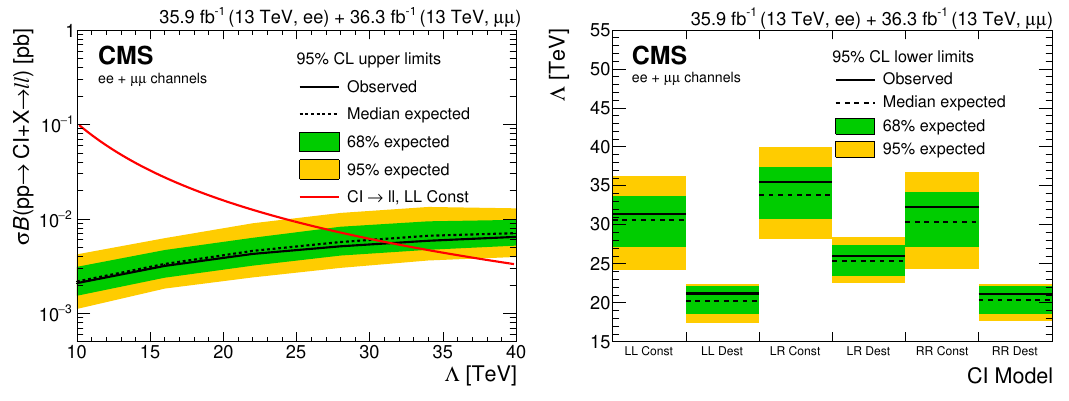
Figure 3 . Combined dilepton 95% CL exclusion limits on the cross section for the left-left con- structive CI model (left), and on the CI scale ((cid:3)) for the six di(cid:11)erent CI models considered (right). The red curve in the left plot shows the theoretical cross section as a function of (cid:3). The limits are obtained for m ‘‘ > 400 (2200) GeV in the case of constructive (destructive) interference. cross section as a function of (cid:3). This is illustrated in (cid:12)gure 3 for the left-left constructive model, where the electron and muon channels are